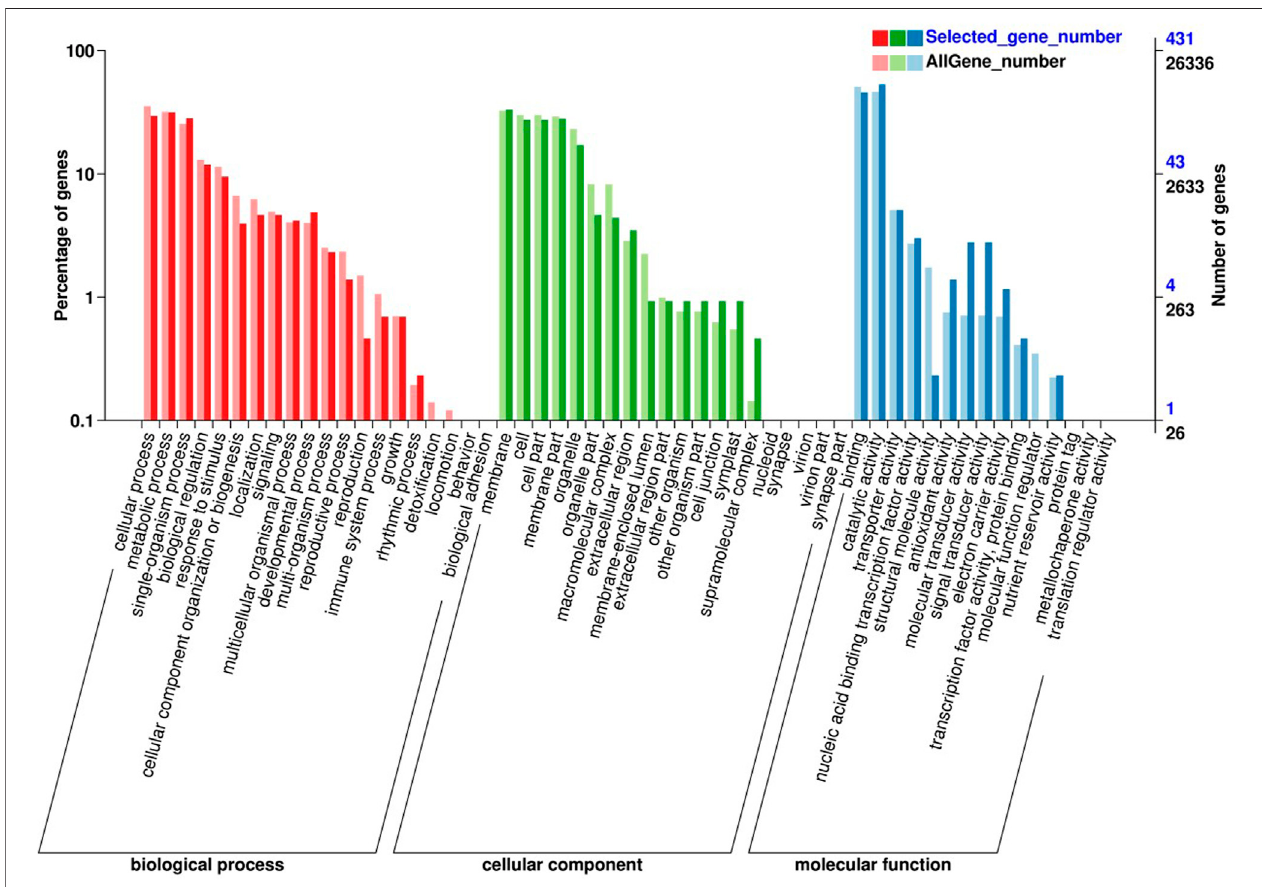
FIGURE 3 | GO enrichment analysis of common DEGs in the early-ripening mutant.